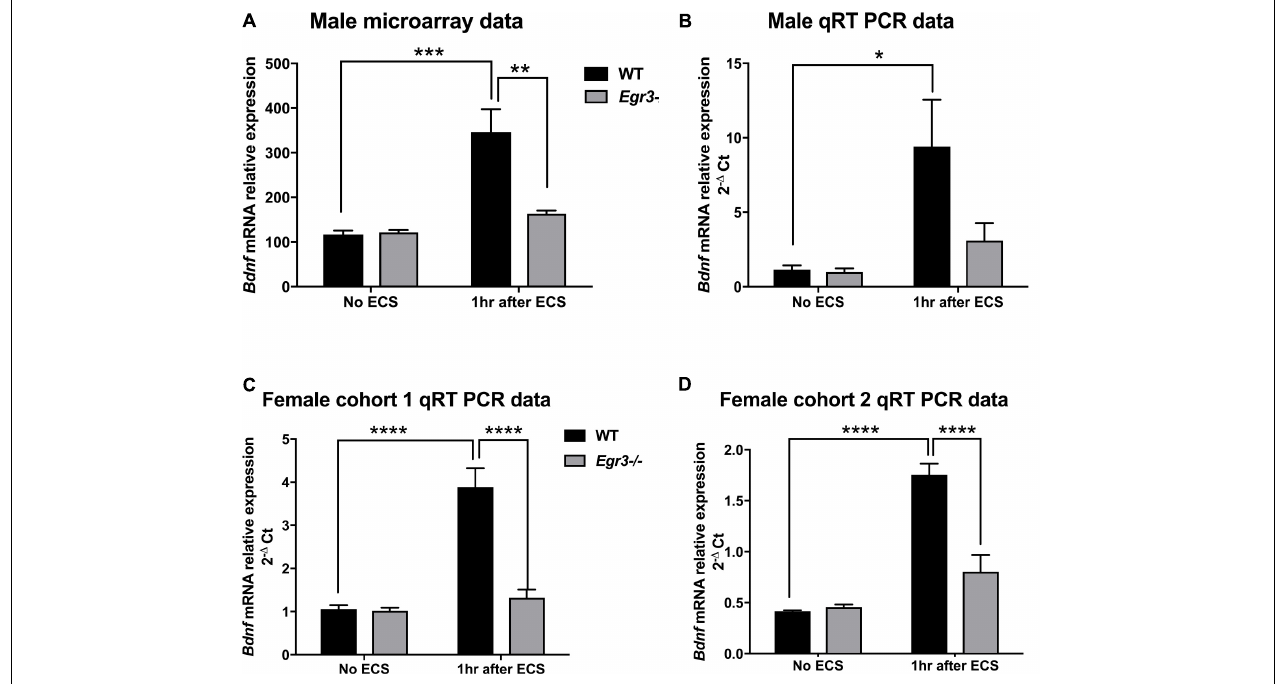
FIGURE 1 | Electroconvulsive seizure (ECS)-induced hippocampal Bdnf expression is Egr3 -dependent. Expression microarray analysis (A) , and validation using qRT-PCR (B–D) , of hippocampal Bdnf expression from WT, and Egr3 –/–, mice at baseline (no ECS) and 1 h after ECS. Two-way ANOVAs showed significant interaction of genotype and ECS treatment on Bdnf expression in (A) male microarray data ( p = 0.004) and qRT-PCR data in (C) female cohort 1 ( p = 0.0005) and (D) female cohort 2 ( p = 0.0003), and (B) significant effect of treatment in original male cohort ( p = 0.0098; n = 4–5 animals/group; ∗ p < 0.05, ∗∗ p < 0.01, ∗∗∗ p < 0.001, and ∗∗∗∗ p < 0.0001 controlled for multiple